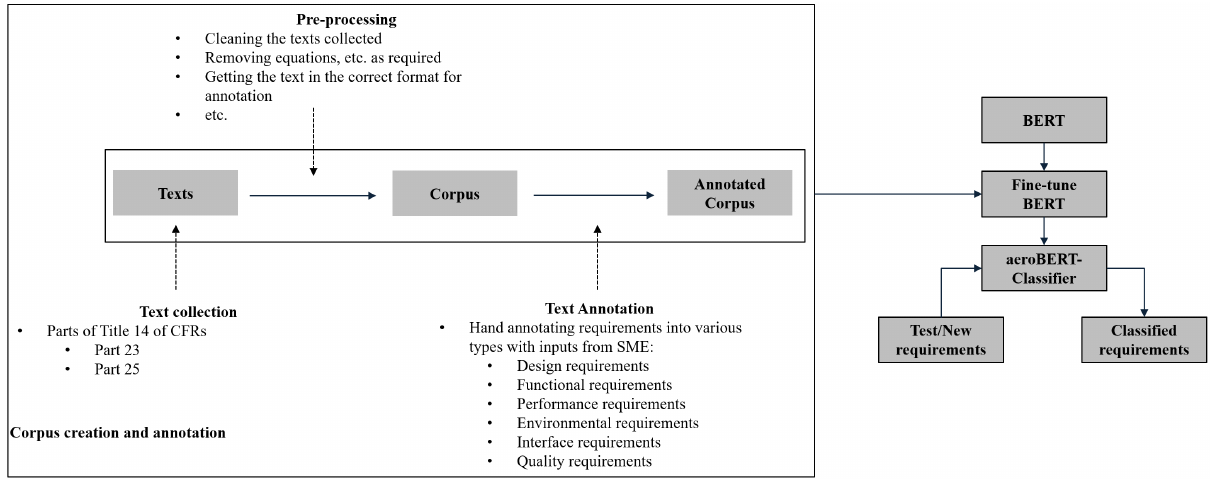
Figure 6. Methodology for obtaining aeroBERT-Classifier.